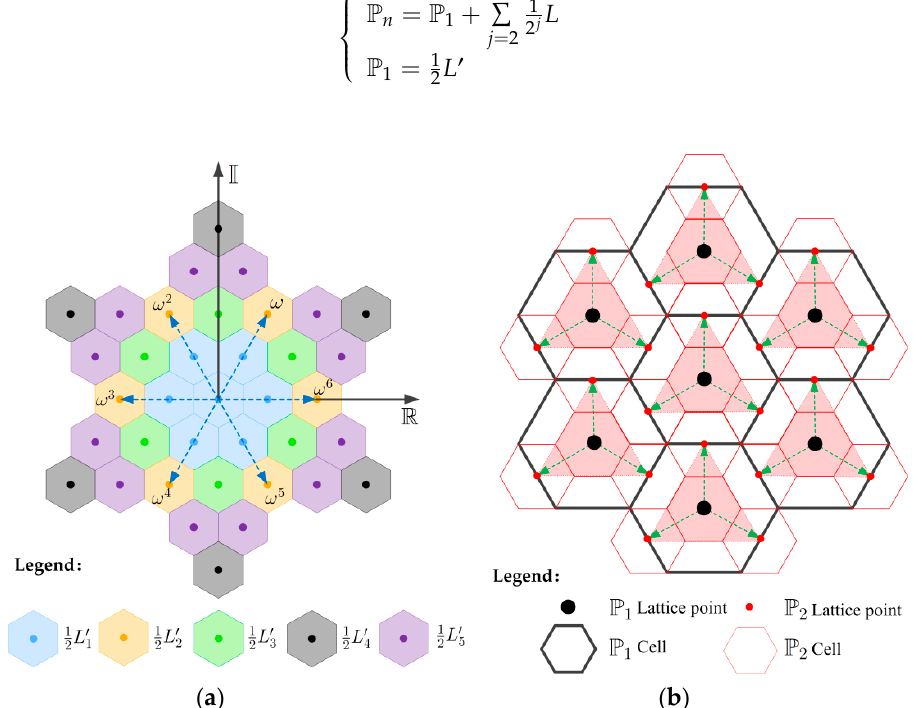
Figure 2. First level of lattice points for face tiles and the quad-tree hierarchy structure: ( a ) distribution of the first-level lattice points on the complex tile plane and ( b ) the quad-tree hierarchical structure of P P and .